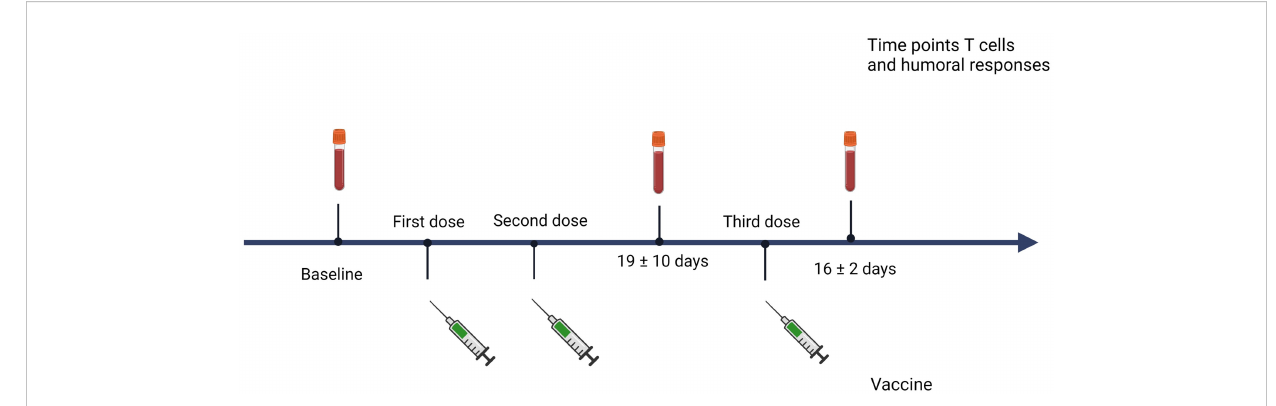
FIGURE 1 Time of sample collection. Created with